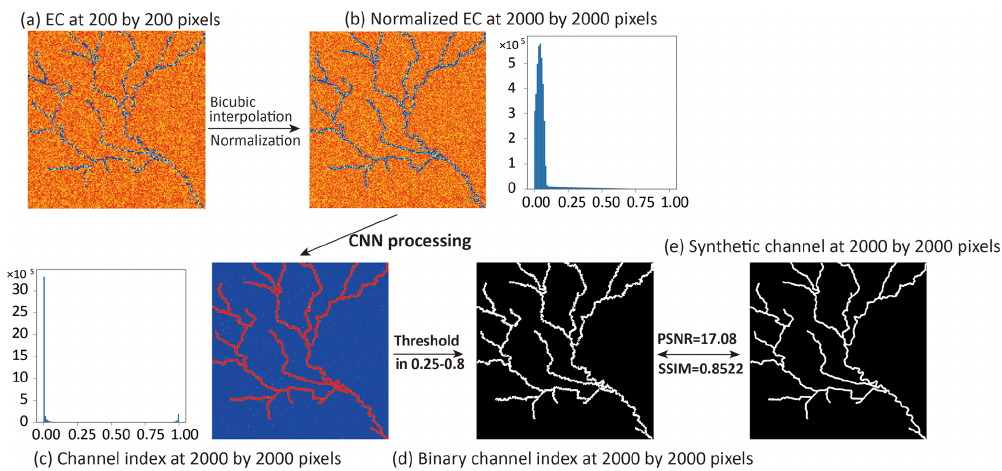
Figure 6. Workflow for generating a binary paleovalley map: (a) upscaling the 200 × 200 pixel electrical conductivity image to (b) a 2000 × 2000 pixel image using bicubic interpolation; (c) SRCNN processing; (d) generating a binary paleovalley at resolution of 2000 × 2000 pixels; (e) binary paleovalley with characteristics comparable to the original synthetic